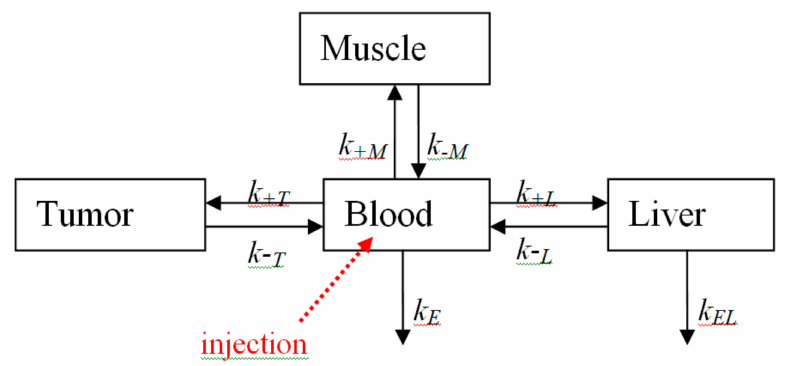
Figure 5. Scheme of a simple multichamber model.